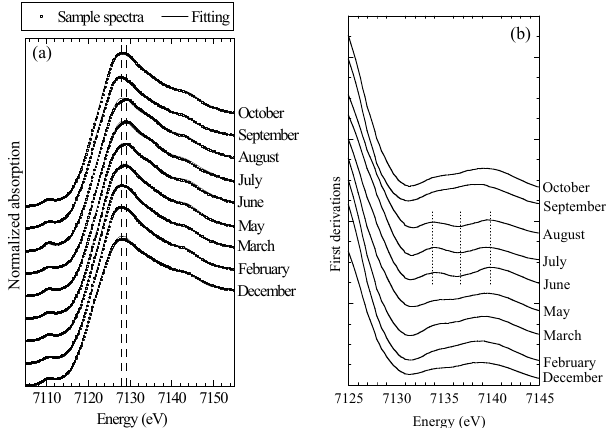
Fig. 5. (a) Fitting of Fe K-edge XANES spectra for aerosols col- lected at various months and (b) their first derivative